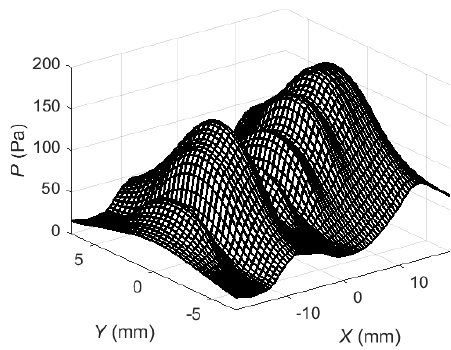
Figure 20. Dependency of peak values of normal displacements U max of the PVC film at the point P ND versus number of the excited elements after applying advance times.